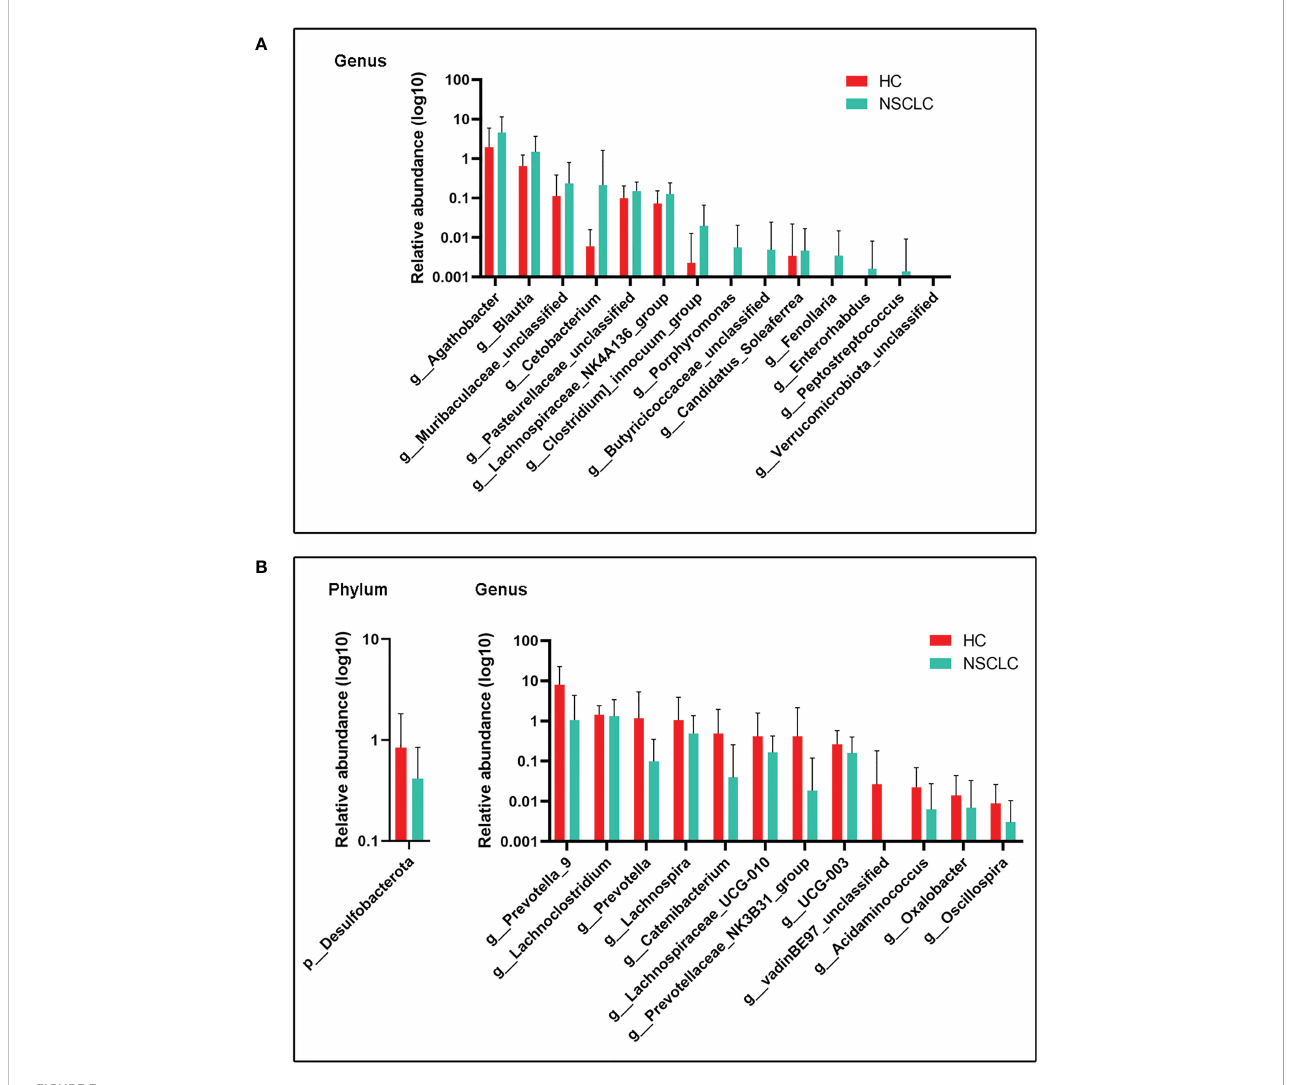
FIGURE 3 Differences in gut microbiota abundance between early-stage NSCLC and HC (A) Increased microbiota abundance in early-stage NSCLC at the genus level (P< 0.05). (B) Decreased microbiota abundance in early-stage NSCLC at the phylum and genus levels (P< 0.05). P values were calculated using the two-tailed Wilcoxon rank-sum